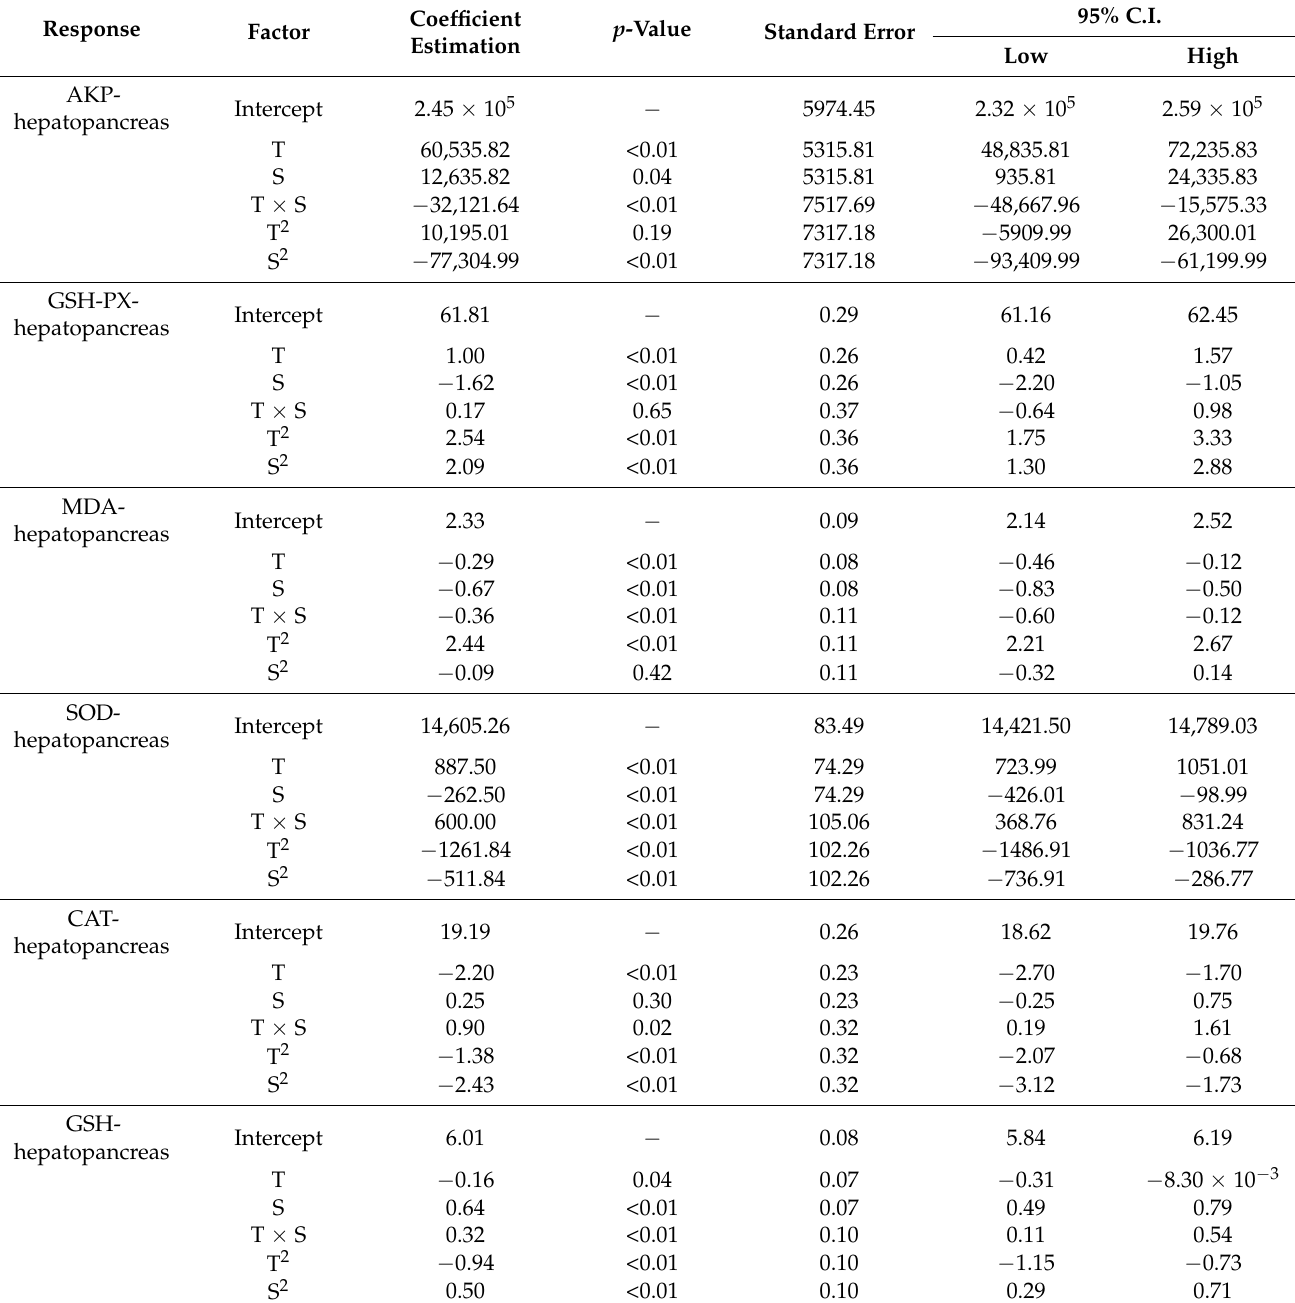
Table 7. Coefficient estimation of the antioxidant and immune indices’ prediction model